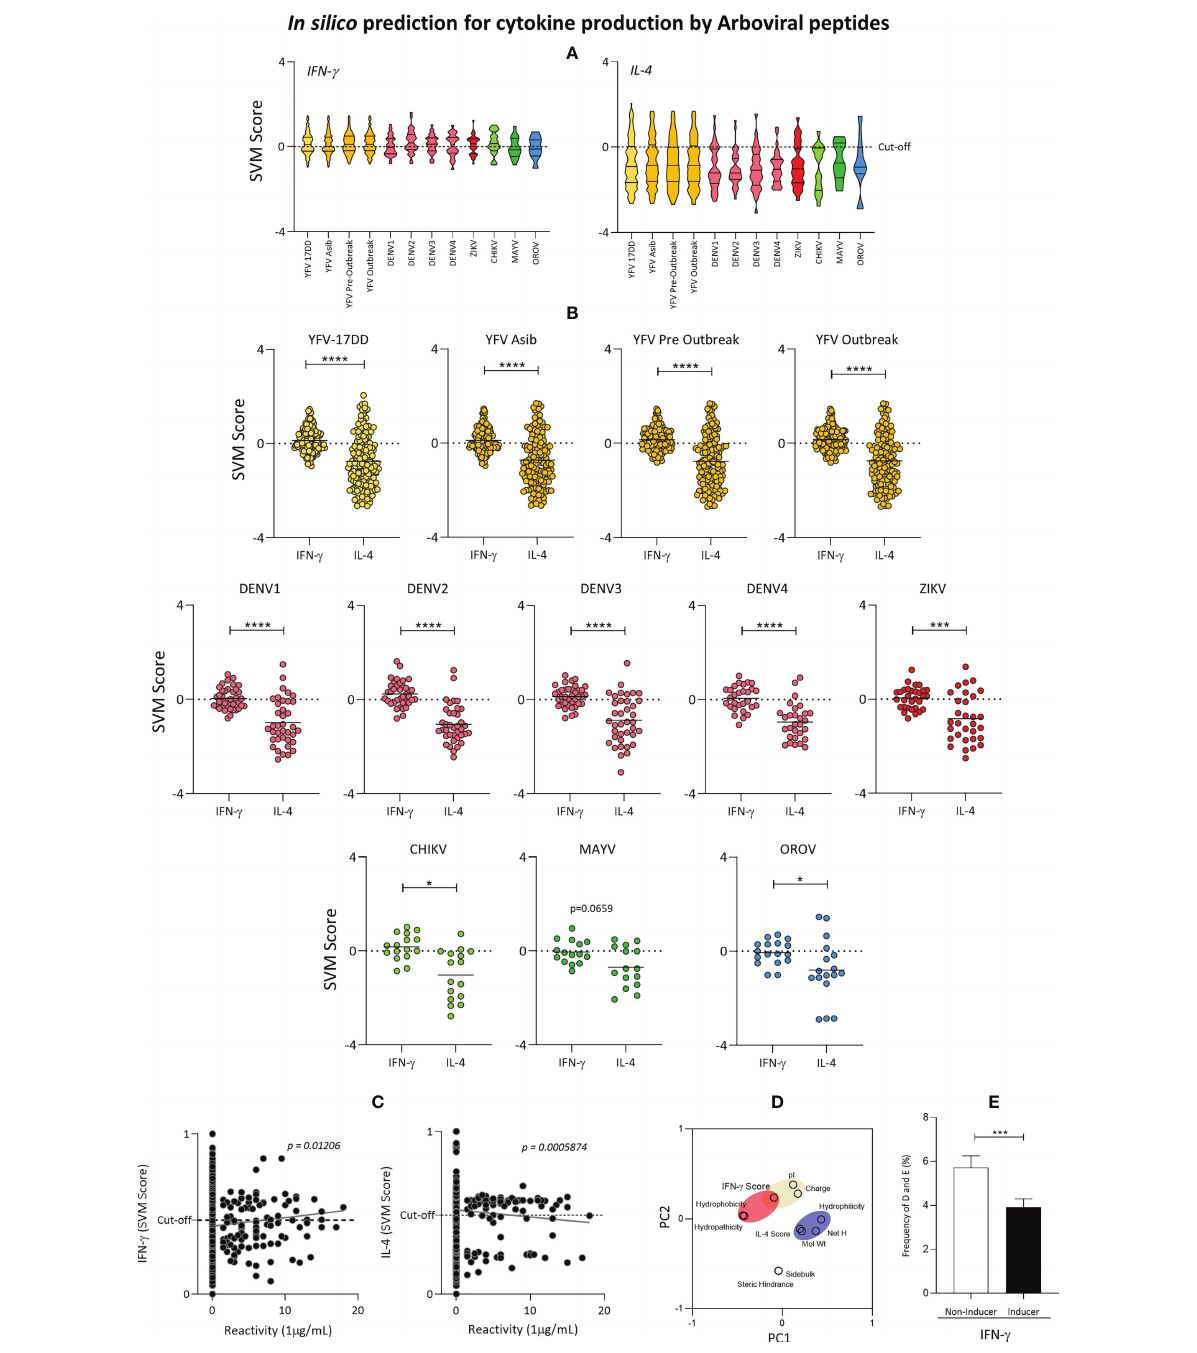
FIGURE 8 Cytokine induction by YFV-17DD Overlapping Peptides. (A) IFN- g and IL-4 production score was assessed by in silico analysis for the peptides from arbovirus. (B) Comparison of IL-4 and IFN- g induction scores within each assessed arbovirus. Dots indicate individual peptides red lines indicate mean with standard deviation. Statistical signi fi cances are indicated by asterisks (* = p<0.01; *** = p<0.0001; **** = p<0.00001). (C) Correlation between cytokine production scores and peptide-HLA-A*02:01 reactivity obtained in vitro was performed for IFN- g (left panel) and IL-4 (right panel) by Spearman ’ s rank test. (D) Principal Component Analysis (PCA) with physicochemical properties of overlapping peptides and in silico scores for cytokine induction. Parameters related to IFN- g induction are clustered in red and in blue for IL-4. (E) Frequency of acid residues [aspartic (E) and glutamic (D) acid] in IFN- g inducer and non-inducer peptides identi fi ed by in silico